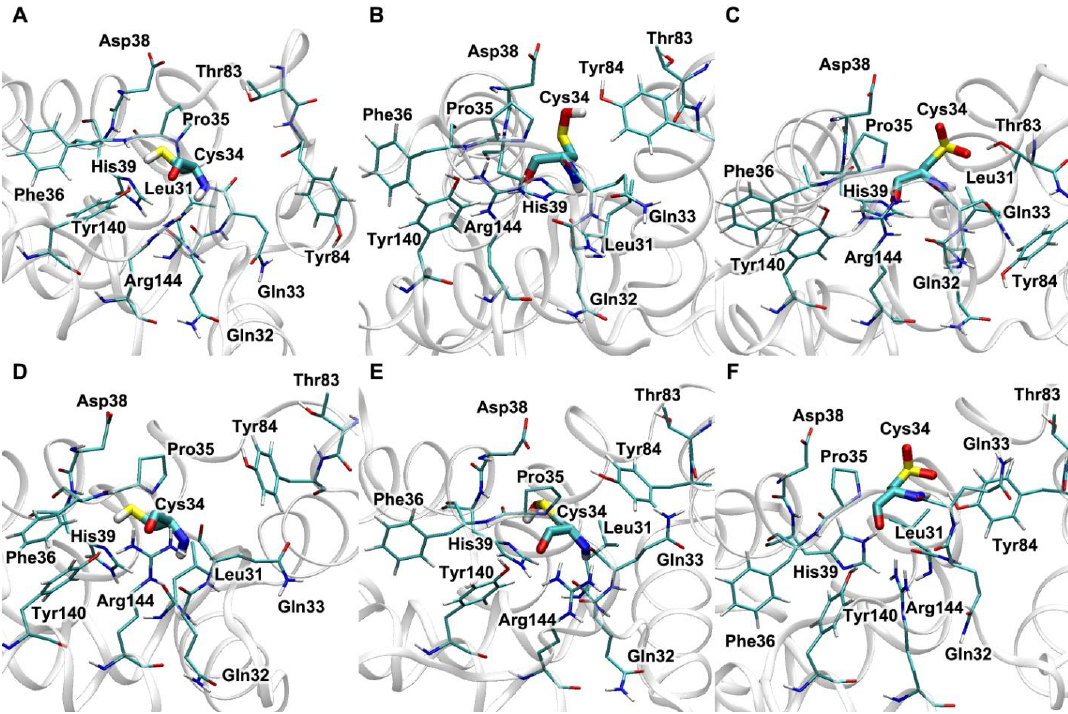
Figure 8. Effect of paraoxon on the conformation of human serum albumin redox site with different oxidation states of Cys34 according to molecular modeling data. ( A – C )—paraoxon is bound in Sudlow site I; ( D – F )—is bound in Sudlow site II; ( A , D )—Cys34 is reduced (Cys34-SH); ( B , E )—Cys34 is oxidised to sulfenic acid (Cys34-SOH); ( C , F )—Cys34 is oxidised to sulfinic acid (Cys34-S(O)O − ).